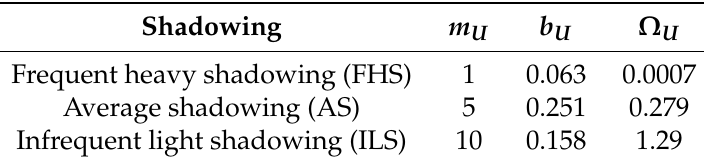
Table 2. Channel